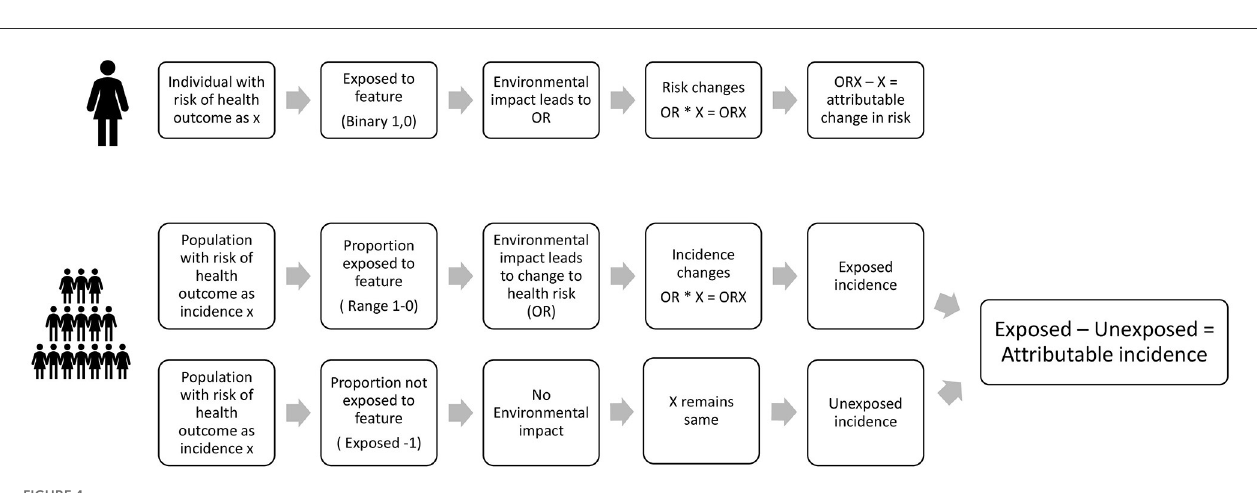
FIGURE4 Estimation of attributable changes in health in HAUS for an individual and for a